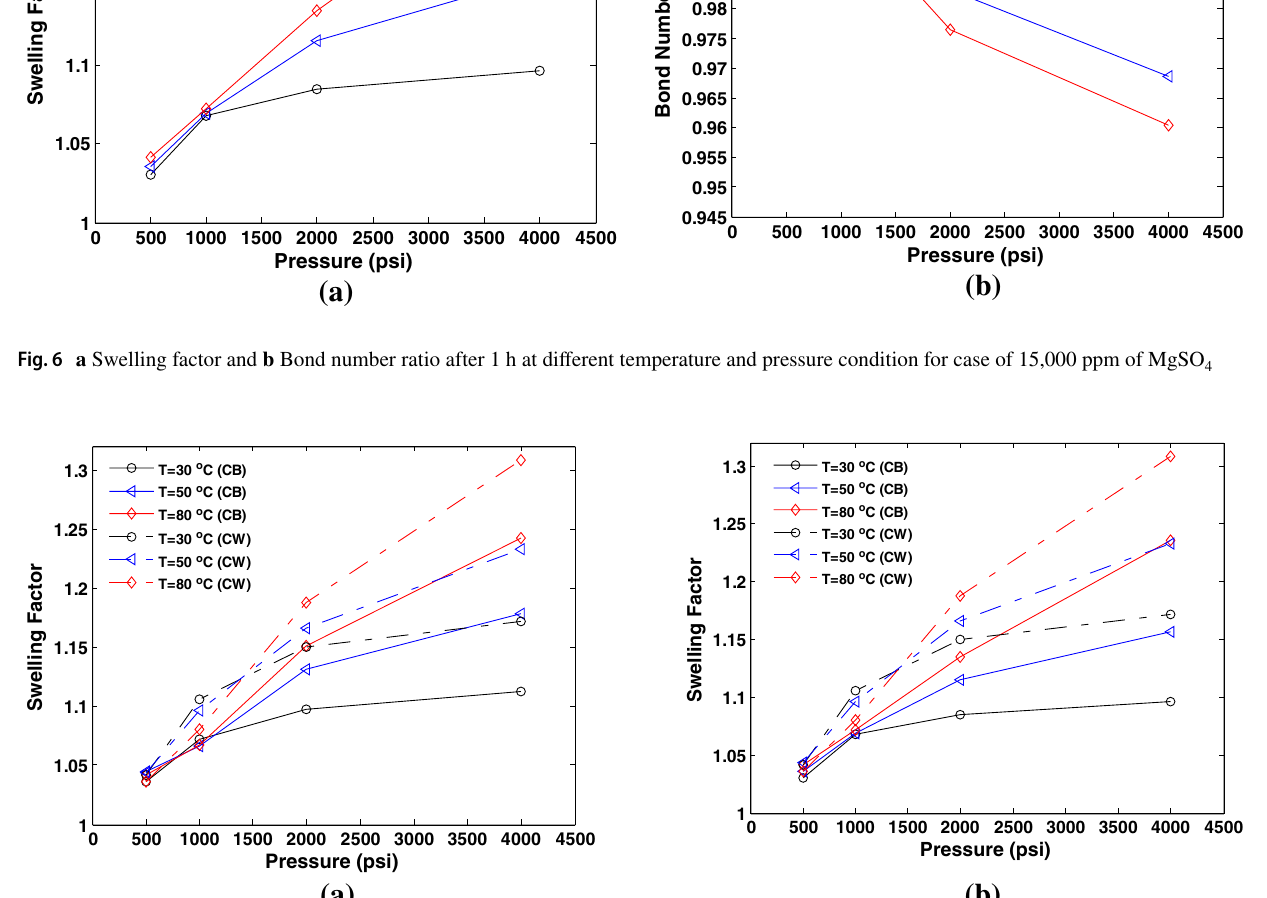
2 SO 4 and b MgSO 4 at different temperature and pressure